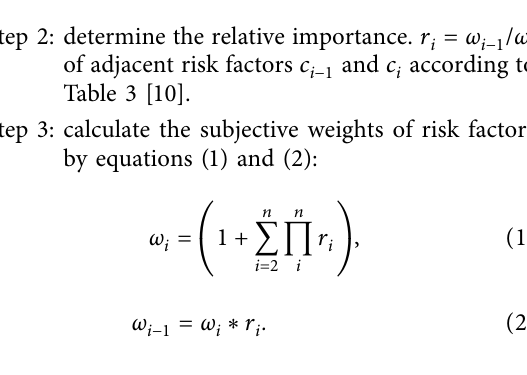
Figure 2: The process of determining risk factors of sponge city PPP